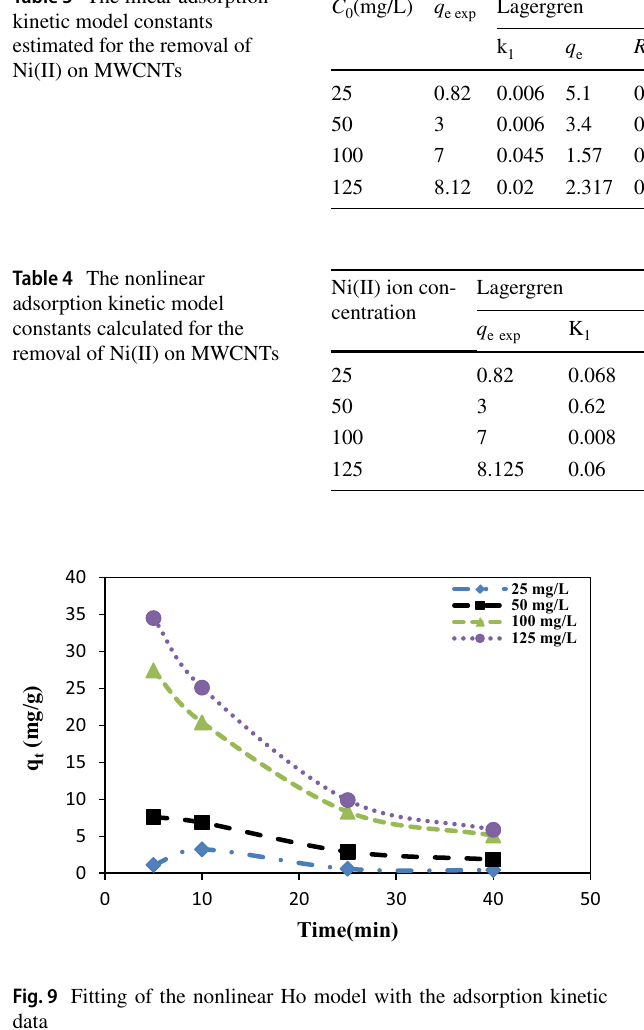
conditions for the most efficient operation of the MWCNTs on Ni(II) removal were achieved at pH of 10, MWCNTs dose of 10 mg/L, concentration of 100 mg/L, and the con- tact time of 10 min which gave a removal efficiency of 82%. The Ho nonlinear model provided a better explana- tion about adsorption kinetic of Ni(II) removal by MWC- NTs. The rate determining step of the adsorption process was found to be chemisorption.